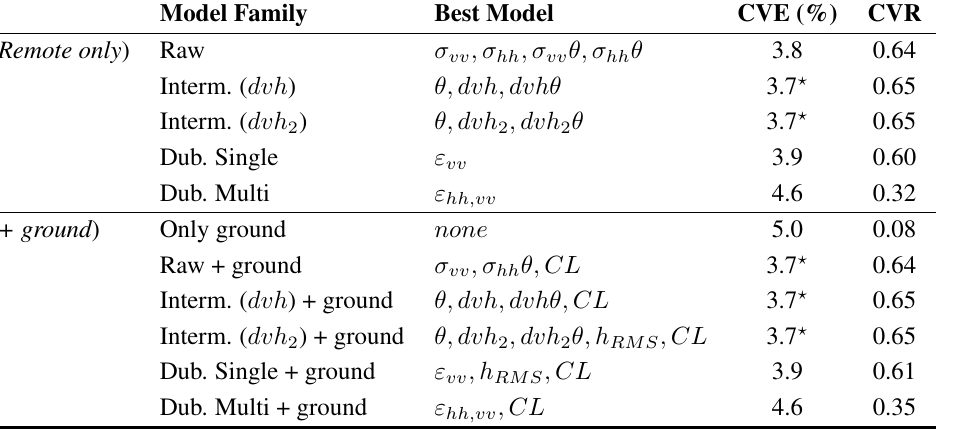
Table 6. Model selection integrated data across all three observational days. The best model(s) in terms of CVE, is (are) denoted by a star. Model Family Best Model